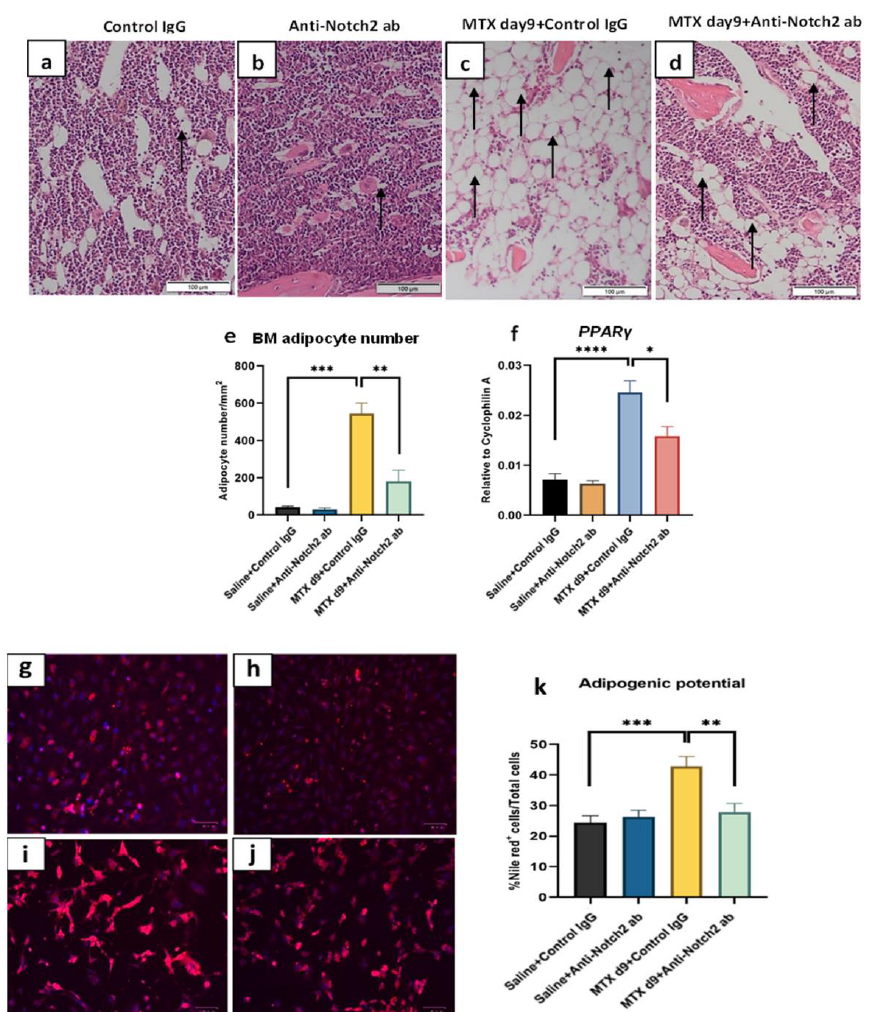
Figure 5. Notch2-neutralising antibody treatment rescued MTX-induced marrow adiposity. Histological images of H&E-stained tibial bone sections (showing mainly bone marrow) of different groups: ( a ) Control IgG, ( b ) anti-Notch2 antibody alone treated, ( c ) MTX + Control IgG treated, and ( d ) MTX + Anti-Notch2 treated; arrows pointing adipocytes; scale bar is 100 µm. ( e ) Treatment effects on bone marrow fat cell density, and ( f ) changes in mRNA expression of adipogenic transcription factor PPARγ. Representative images for adipogenic cultures with Nile red staining of different groups: ( g ) control IgG group, ( h ) anti-Notch2 antibody control, ( i ) MTX + Control IgG, ( j ) MTX + anti-Notch2 antibody group. Red colours represent stained intracellular lipid droplets and blue colours dapi stained nuclei; scale bar is 100 µ m. ( k ) Quantification of adipogenic potential assessed by Nile red staining and expressed as percentage of Nile red + cells; * p < 0.05, ** p < 0.01, *** p < 0.001, **** p <